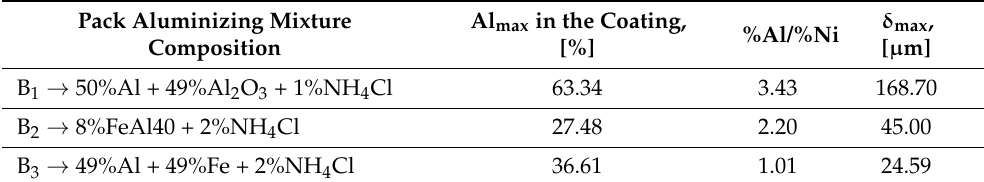
Table 2. Comparative analysis of the results of pack cementation with the active components in various states (free, bonded or in the bonded process) of the IN 718 superalloy (processing parameters: 900 ◦ C/5